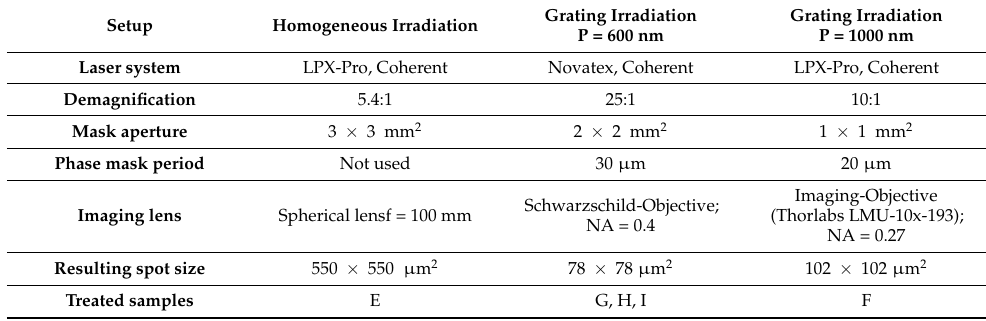
Table 1. Crucial parameters of the three different laser setups used for sample irradiation. Laser systems from Coherent, Göttingen,